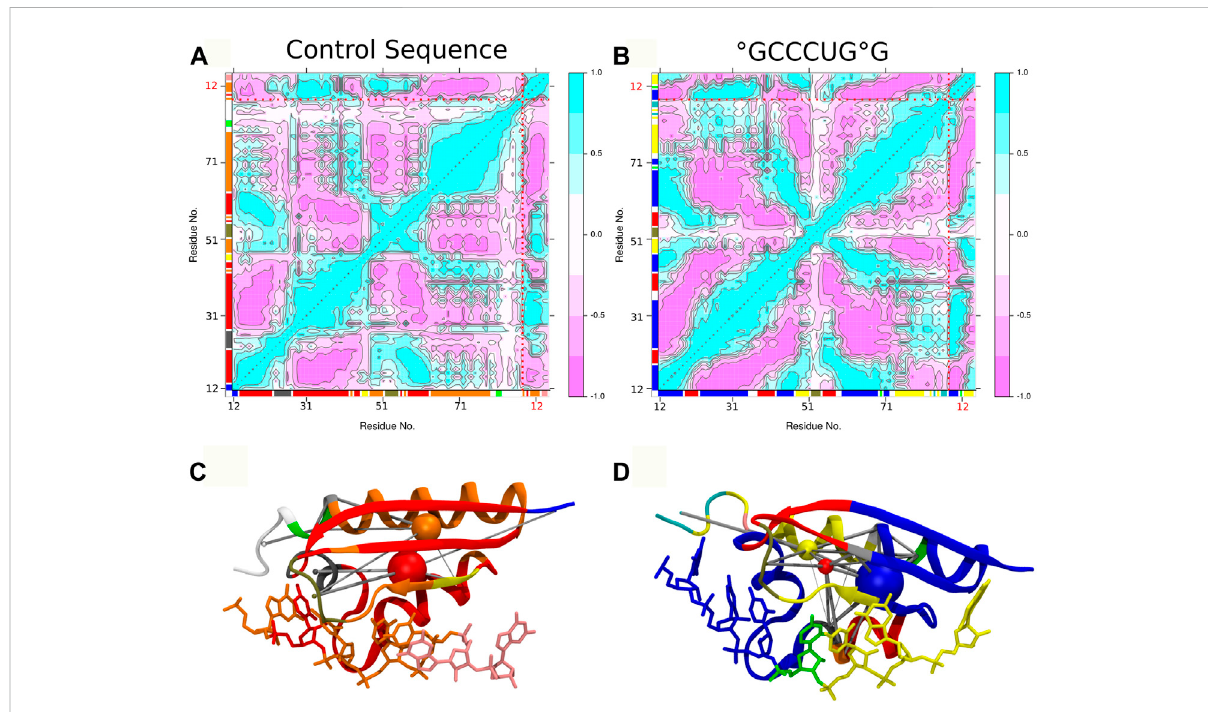
FIGURE 7 Dynamic cross correlation of residue pairs and corresponding dynamic networks for control (A,C) and ° GCCCUG ° G (B,D) sequences. In both graphs, the dotted red lines indicate the separation of the protein and 9 to 15 RNA residues and the axis color corresponding to the network community of each residue. In the 3D representation of networks, the residues are colored according to their dynamic community represented by nodes (colored spheres) connected by the edges (gray cylinders), according to the dynamic cross correlation between